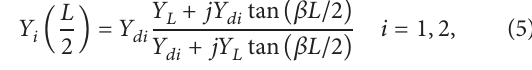
Figure 11: The measured and simulated return loss of the proposed antenna.